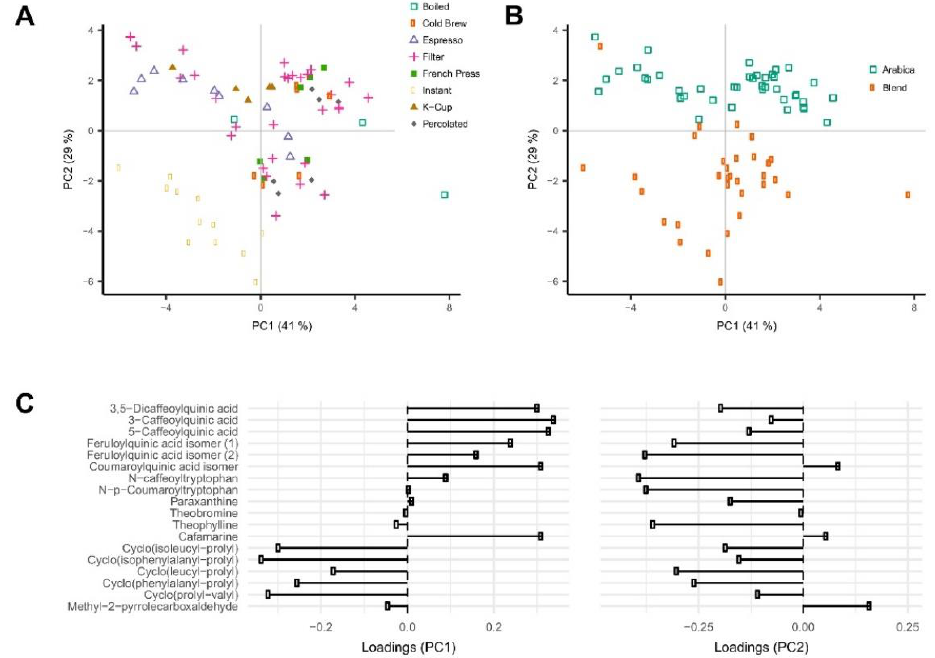
Figure 6. Discrimination of 76 coffee samples using principle component analysis: PCA scores of different coffee brews ( A ) and different coffee beans variety ( B ) and corresponding PCA loading plots ( C ) [149].